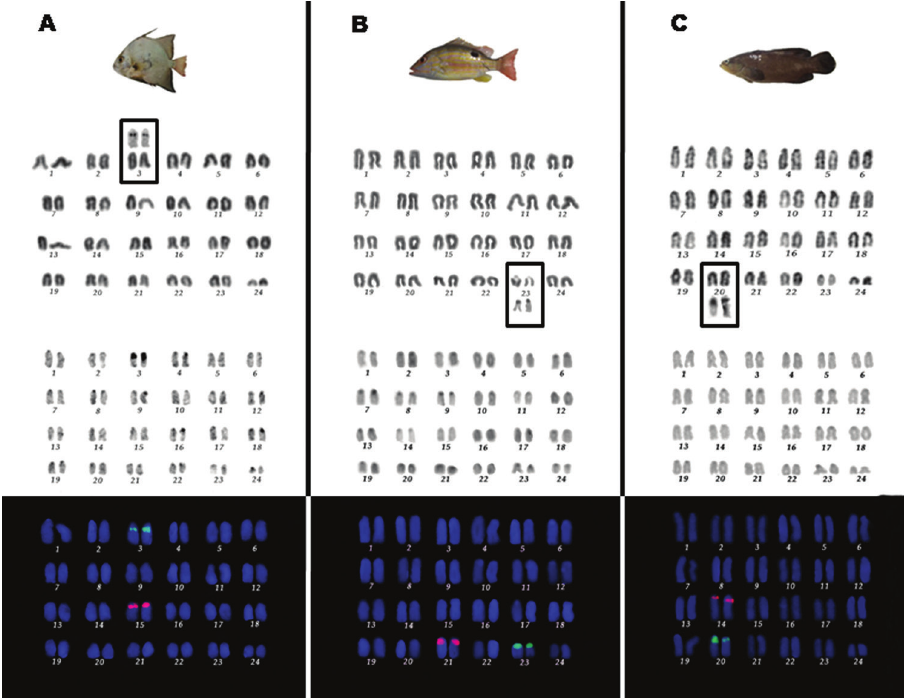
Figure 1. Karyotypes of Chaetodipterus faber ( A ), Lutjanus synagris ( B ), and Rypticus randalli ( C ) with 2n=48 acrocentric chromosomes after conventional Giemsa-staining (top), C-banding (center) and dou- ble FISH with 18S (green signals) and 5S (magenta signals) rDNA probes (bottom). In boxes, the pairs bearing nucleolus organizer regions after silver nitrate staining